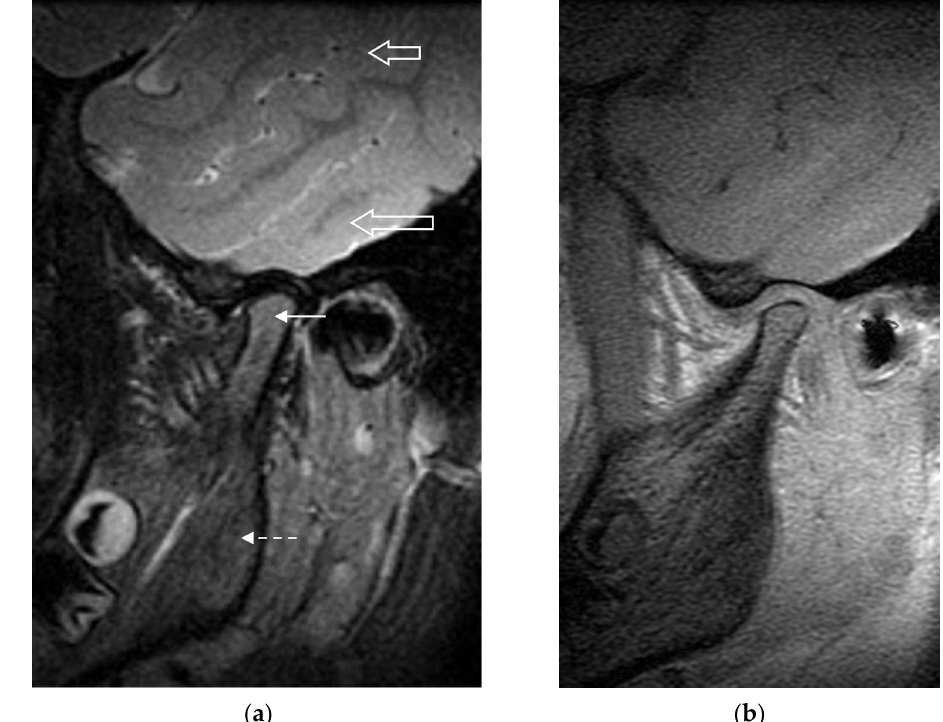
Figure 2. ( a ) Sagittal T2-weighted fat suppressed MR image of the left temporomandibular joint in a 9-year-old girl. The signal intensity of the bone marrow in the mandibular condyle (solid arrow) is increased compared to the signal intensity of that in the mandibular ramus (dashed arrow). Following the exact definition of bone marrow edema in the scoring system would cause this to be scored as grade 1 (present) bone marrow edema. However, this increased signal intensity is likely secondary to the generally higher signal in structures at the center of the field of view versus those at the periphery: notice the higher signal intensity of brain parenchyma nearer the center of the image (lower open arrow) versus that at the periphery of the image (upper open arrow). If this were true marrow edema, the signal intensity on the corresponding precontrast T1-weighted image ( b ) would be expected to be decreased, which was not the case.